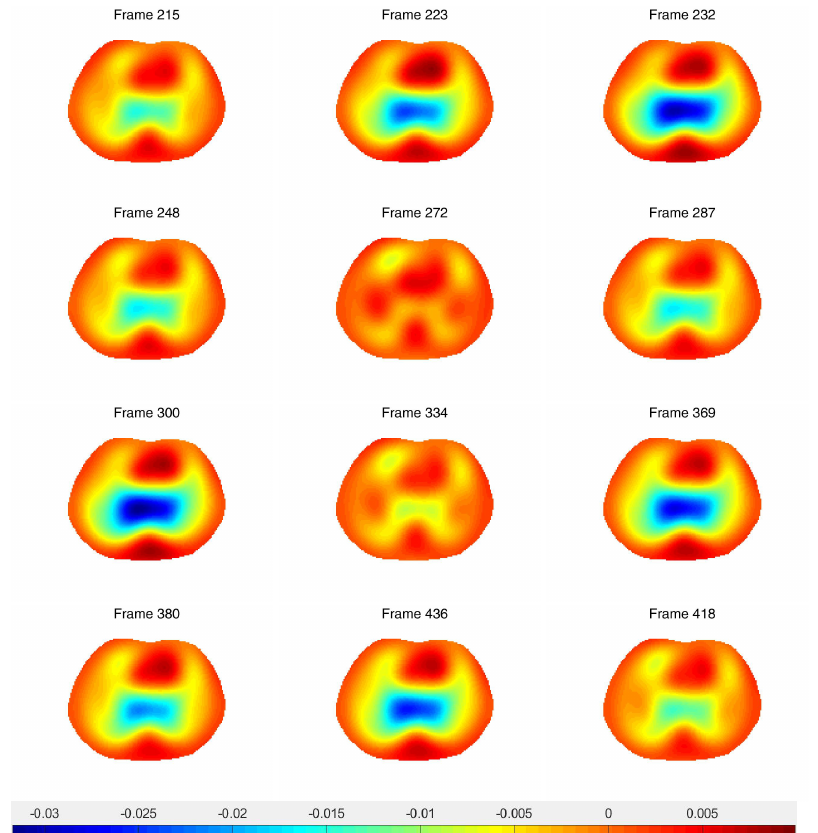
Figure 9. Difference images of ventilation data with the spatial prior included in the algorithm. Frame 200 is used for the reference image. The truncation radius is 1.2 and the outer truncation radius is 3.